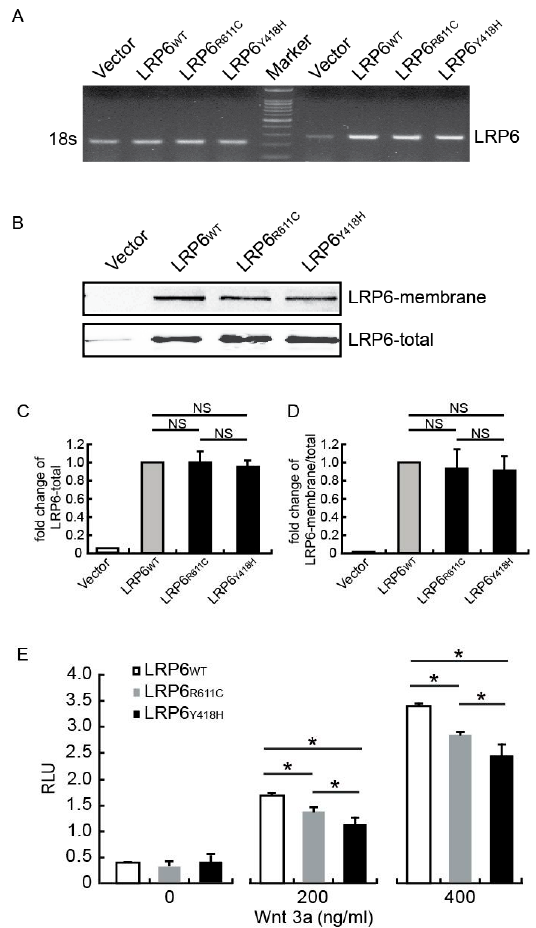
Figure 2. Effect of LRP6 Y418H and LRP6 R611C on Wnt signal transduction. ( A ) RT-PCR showed that there was no significant difference between the over-expression levels of LRP6 WT /LRP6 R611C /LRP6 Y418H ; ( B ) Western blot showed no significant difference between total expression levels or membrane location of wild-type and mutant LRP6. Results were replicated three times and a representative figure was shown; ( C , D ) Statistical result of ( B ); ( E ) Luciferase assay was performed with different amount of Wnt3a. RLU: relative light units. Results were obtained with four independent transfections. Error bars, standard deviation. * indicate p -value for one-way ANOVA plus post-hoc test <0.05. NS, not significant in one-way ANOVA plus post-hoc test.